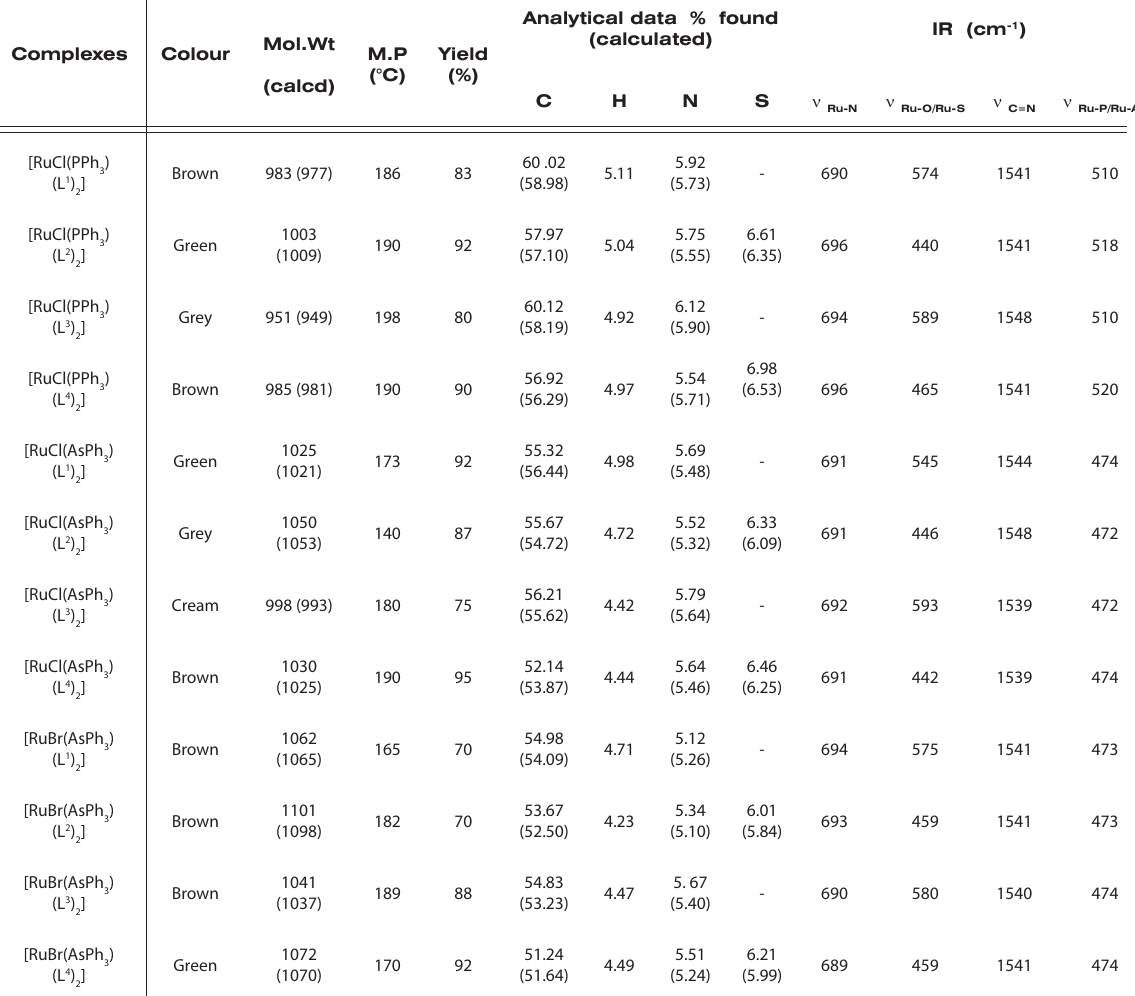
Table 1. Analytical and FT-IR spectroscopic data of the complexes